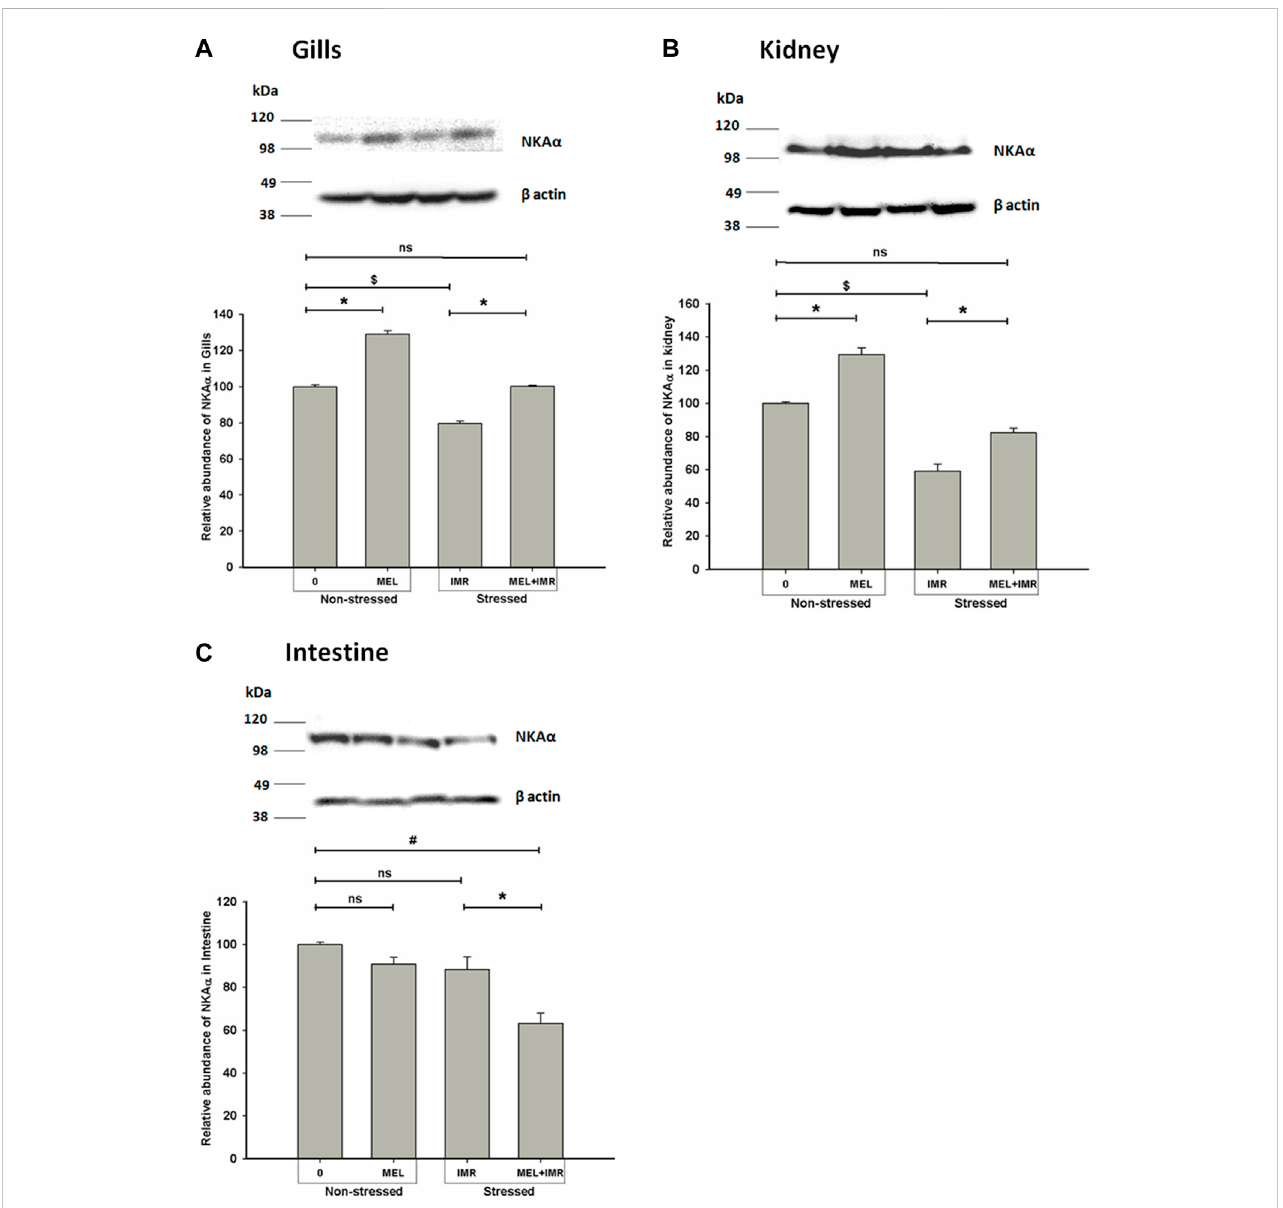
FIGURE 5 Representative western blots showingimmunoblotting ofNKA α subunit protein abundance ingills (A) , kidney (B) and intestine (C) after invivo melatonin (50 ng g − 1 ) treatment (Mel in non-stressed and immersion-stressed fi sh (IMR). β -actin was used as an internal control for the densitometric analysis. Protein was harvested from each group and the signi fi cance between groups was accepted at p < .05 level. “ * ” represents signi fi cance between non-stressed control (0) and melatonin (MEL) treated or comparison between IMR and MEL + IMR fi sh. “ # ” denotes signi fi cance between non-stressed control (0) and MEL + IMR fi